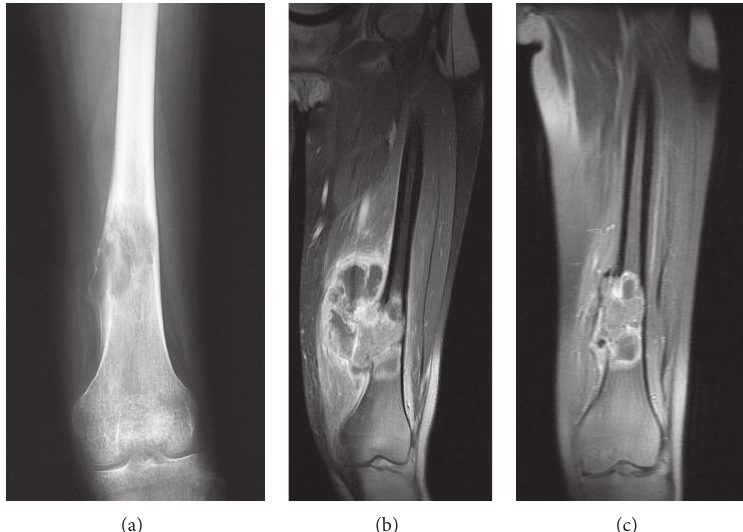
Figure 2: A plain radiograph of the left distal femur demonstrates an osteolytic lesion with destruction of the cortex and intratumoral ossification (a). Coronal MR images demonstrate a large extraosseous mass with destruction of the cortex (b). Reduction in size of the tumor was noted after preoperative chemotherapy (c).